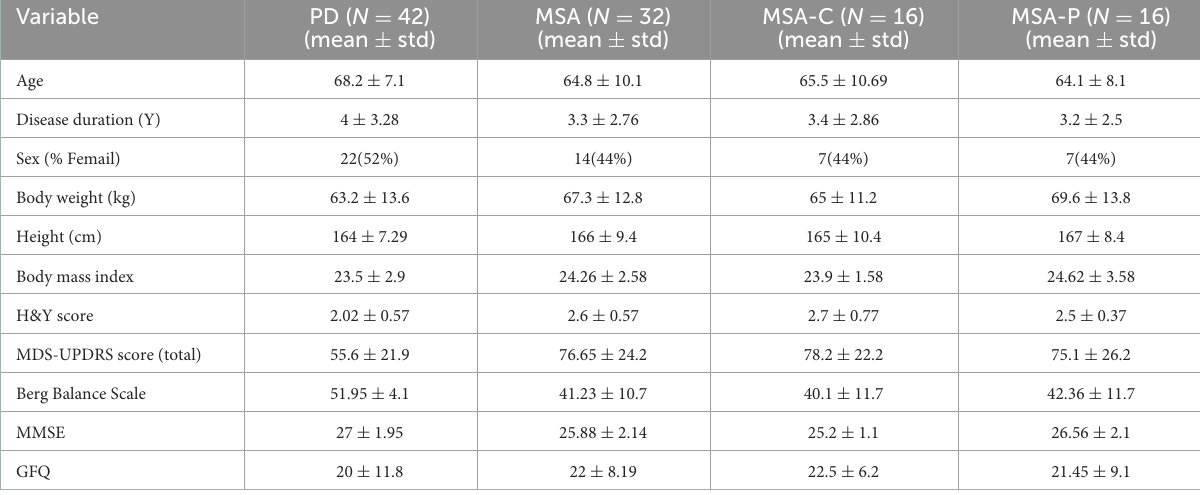
(34). Table 2 lists the specific expressions of the four